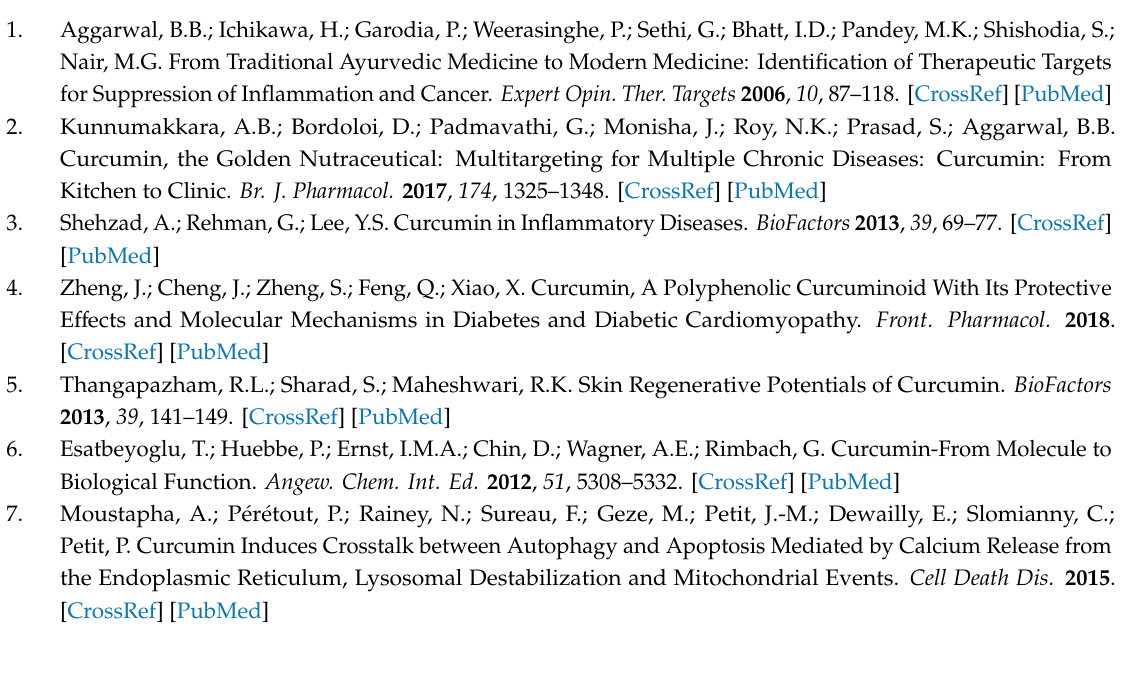
Figure S1. Time-dependent UV-Vis spectra of curH in DMSO. Figure S2. Time-dependent UV-Vis spectra of [Zn(CH 3 COO)(cur)(bpy)]( 1 ) in DMSO. Figure S3. Time-dependent UV-Vis spectra of [Zn(PhCOO)(cur)(bpy)]( 2 ) in DMSO. Figure S4. Time-dependent UV-Vis spectra of curH in 90 vol.% 100 mM NaCl - 10 vol. % DMSO. Figure S5. Time-dependent UV-Vis spectra of [Zn(CH 3 COO)(cur)(bpy)]( 1 ) in 90 vol.% 100 mM NaCl - 10 vol. % DMSO. Figure S6. Time-dependent UV-Vis spectra of [Zn(PhCOO)(cur)(bpy)]( 2 ) in 90 vol.% 100 mM NaCl - 10 vol. % DMSO. Figure S7. Time-dependent UV-Vis spectra of curH in 90 vol.% PBS (pH = 7.0) - 10 vol.% DMSO solution. Figure S8. Time-dependent UV-Vis spectra of [Zn(CH 3 COO)(cur)(bpy)]( 1 ) in 90 vol.% PBS (pH = 7.0) - 10 vol.% DMSO solution. Figure S9. Time-dependent UV-Vis spectra of [Zn(PhCOO)(cur)(bpy)]( 2 ) in 90 vol.% PBS (pH = 7.0) - 10 vol.% DMSO solution. Figure S10. 1H NMR spectrum (500 MHz) of [Zn(CH 3 COO)(cur)(bpy)]( 1 ) in DMSO-d6. Figure S11. 1H NMR spectrum (500 MHZ) of [Zn(PhCOO)(cur)(bpy)]( 2 ) in DMSO-d6. Figure S12. 1H NMR spectrum (500 MHz) of [Zn(PhCOO) 2 ] in DMSO-d6. Figure S13. 2D [ 1 H, 1 H] COSY NMR (500 MHZ) spectrum of [Zn(CH 3 COO)(cur)(bpy)]( 1 ) in DMSO-d6. Figure S14. 2D [ 1 H, 1 H] COSY NMR (500 MHZ) spectrum of [Zn(PhCOO)(cur)(bpy)]( 2 ) in DMSO-d6. Figure S15. ATR-IR spectrum of curH. Figure S16. ATR-IR spectrum of [Zn(CH 3 COO)(cur)(bpy)]( 1 ) · CH 3 OH · 2H 2 O. Figure S17. ATR-IR spectrum of [Zn(PhCOO)(cur)(bpy)]( 2 ) · CH 3 OH. Figure S18. ATR-IR spectrum of [Zn(PhCOO) 2 ]. Figure S19. TGA curve of [Zn(CH 3 COO)(cur)(bpy)]( 1 ) · CH 3 OH · 2H2O, recorded after being exposed to air. Figure S20. TGA curve of crystals of [Zn(PhCOO)(cur)(bpy)]( 2 ) · CH 3 OH, recorded after being exposed to air. 23 Figure S21. TGA curve of [Zn(PhCOO) 2